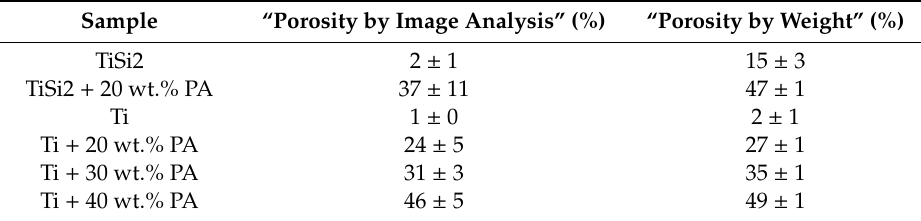
Table 1. Resulted